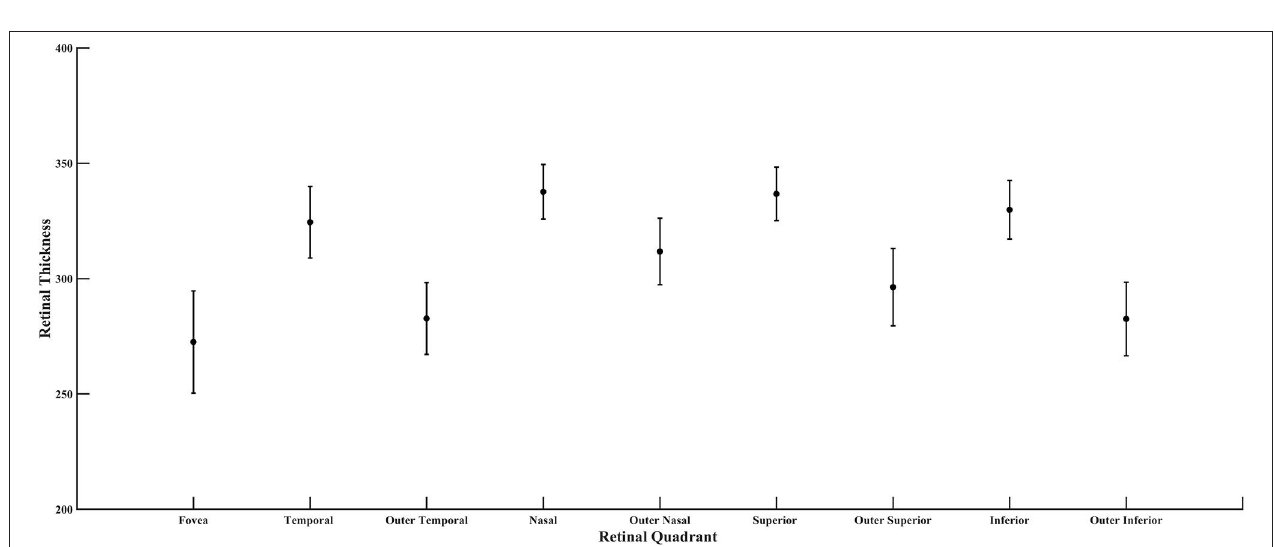
FIGURE 8 | Retinal thickness of the diabetic subjects for all quadrants of the ETDRS grid, plotted as mean and standard